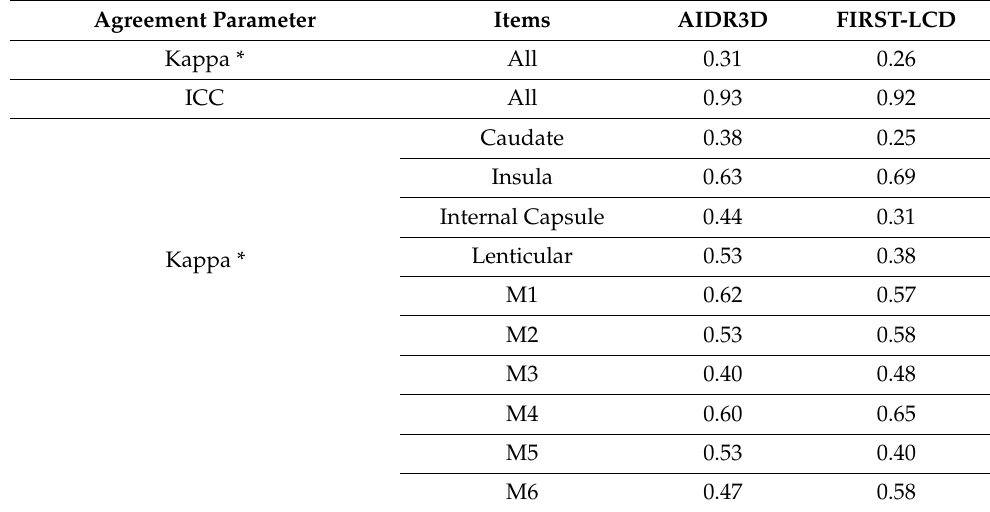
Table 2. Inter-reader